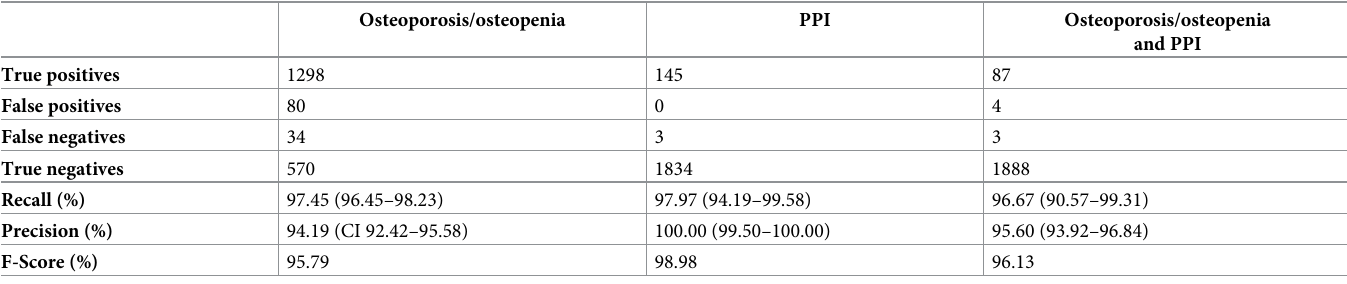
Table 3. Evaluation of the automated extraction versus gold